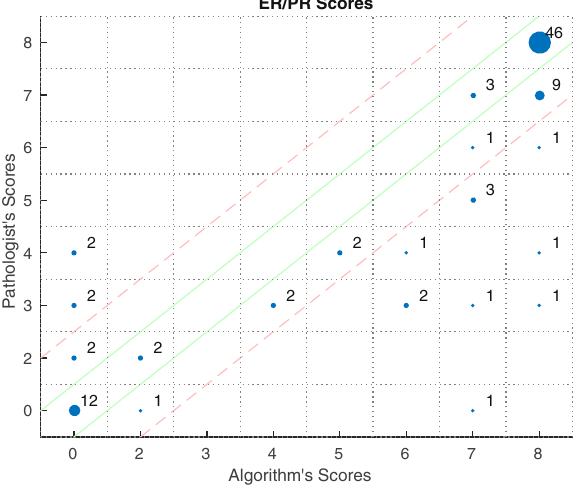
Figure 4. Scatter plot showing the results of the automatic ER/PR scoring, compared to the pathologist’s manual scores. Size of the dot is proportional to the number of cases with the given Pathologist-Algorithm score pair, the number of cases is also placed alongside the dot. All results between the solid green lines have the same score as the pathologist. All results between the dotted red lines are within one of the pathologist’s